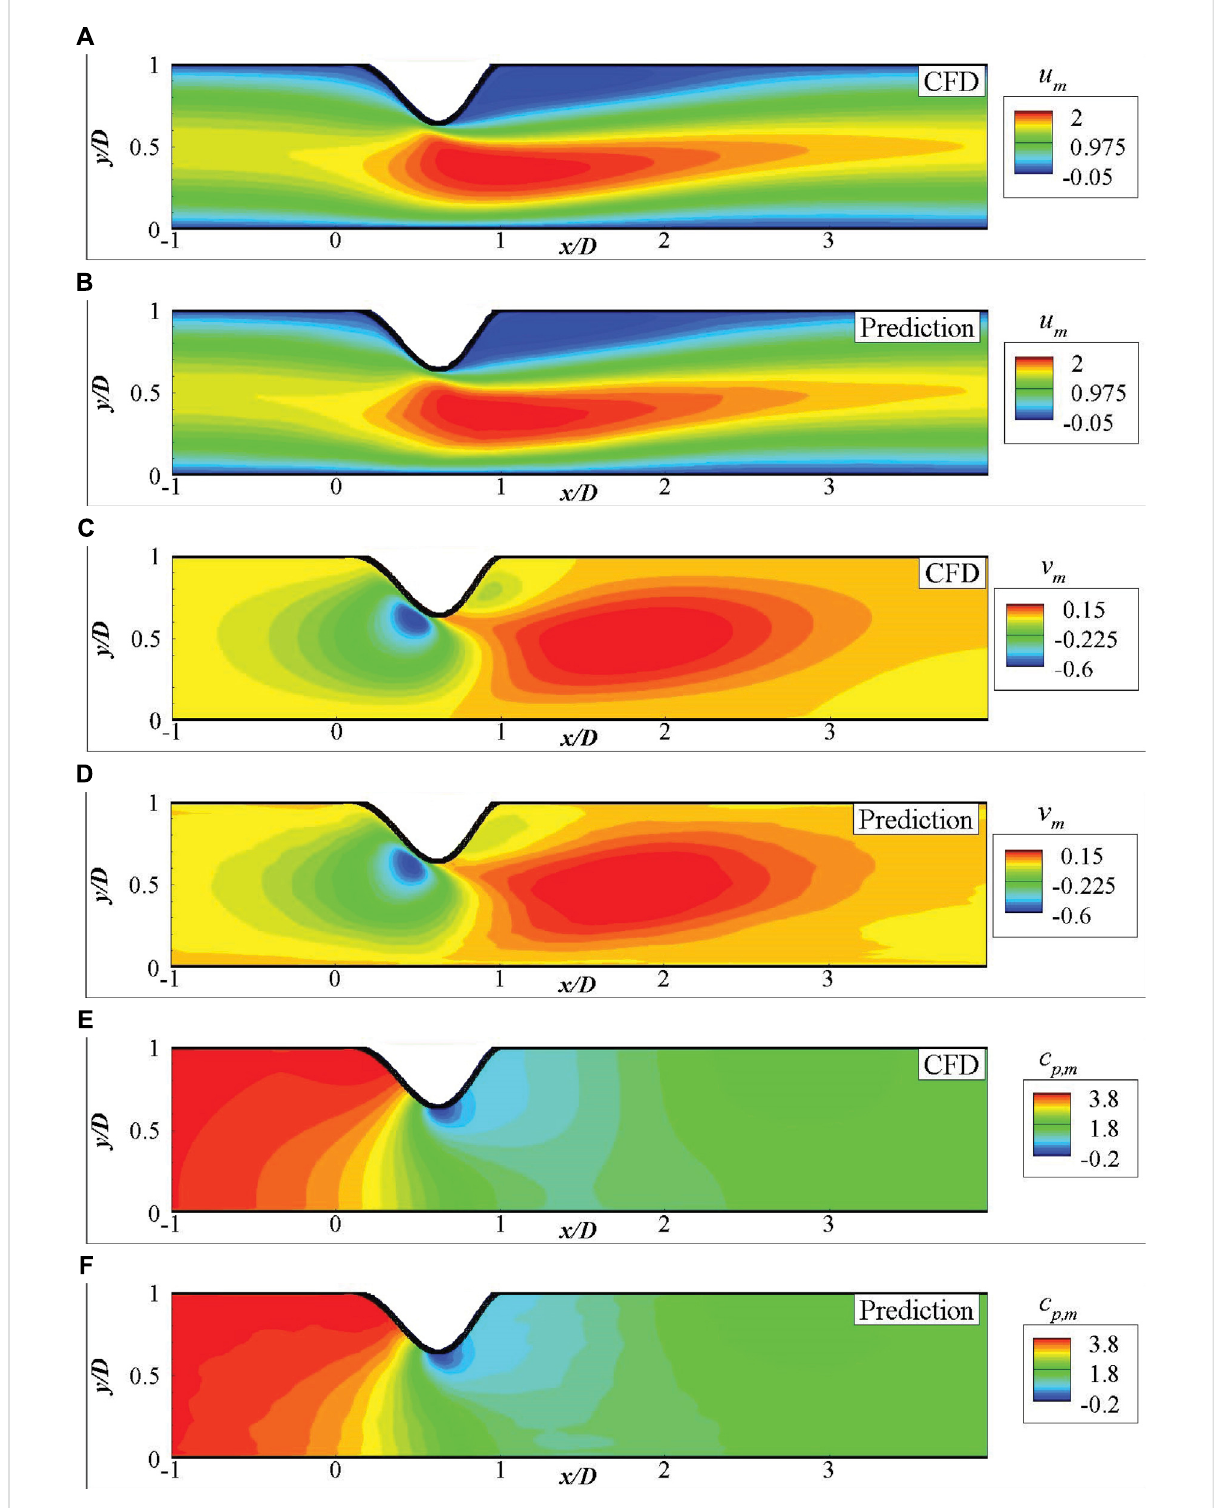
FIGURE 7 Comparison of the mean fl uid fi elds for 2D channel fl ows from DNN prediction and CFD simulation: (A) u m by CFD, (B) u m by DNN prediction, (C) v m by CFD, (D) v m by DNN prediction, (E) c p , m by CFD, (F) c p , m by DNN